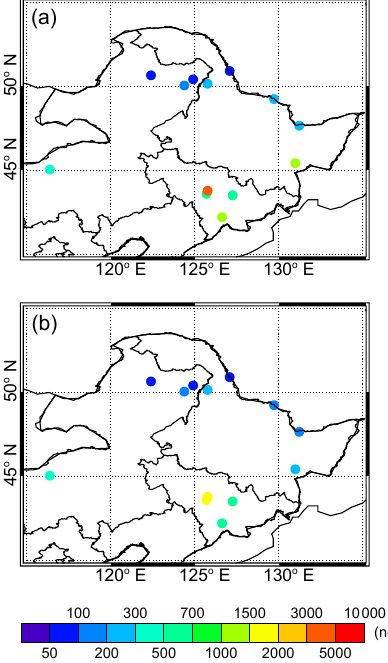
in the (a) surface and BC